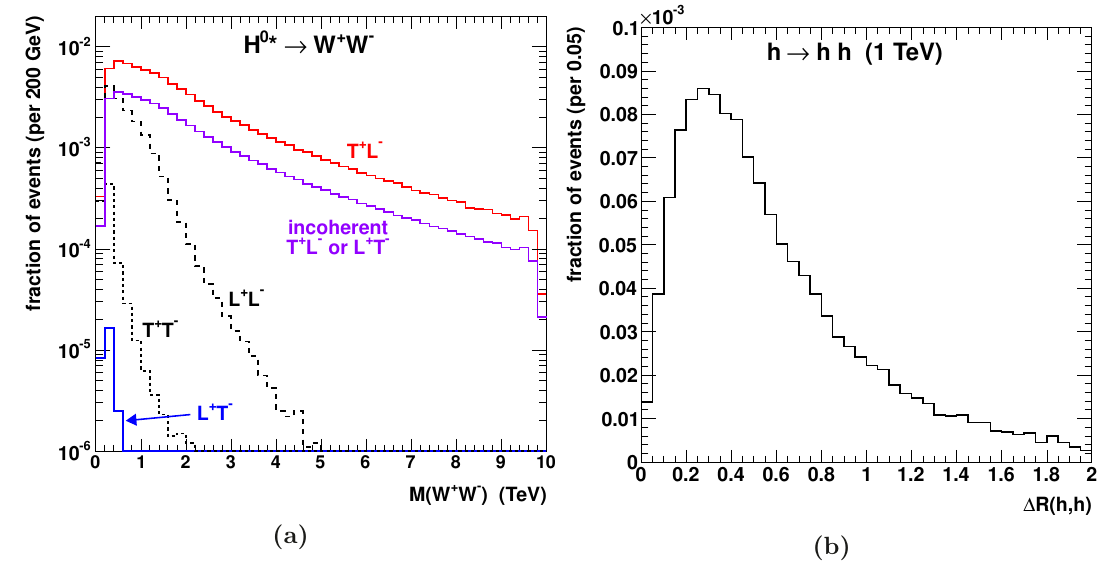
Figure 9. (a) W + W − invariant mass distributions from the EW splitting of a 10 TeV h/Z L ( H 0 ∗ ) W + W − , labeled by the helicities and charges as T + L − , L + T − , T + T − , and L + L − . → The “incoherent T + L − or L + T − ” curve shows the corresponding result from showering h and Z L states independently. (b) Kinematic ∆ R separation between the final state Higgs boson pair for the ultra-collinear splitting process h hh from a 1 TeV Higgs →